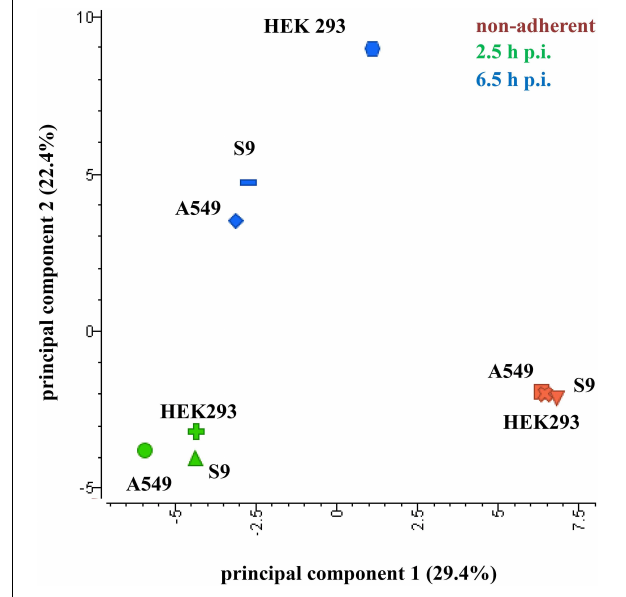
FIGURE 3 | Principal component analysis of S. aureus proteins. Samples were separated by the cell lines (component 1, 29.4% variance) as well as the different treatment groups (component 2, 22.4% variance). Only proteins with quantitative data for all samples, (median normalized AUC data, probability > 0.8) were considered for the analysis. Data from three biological replicates are represented.